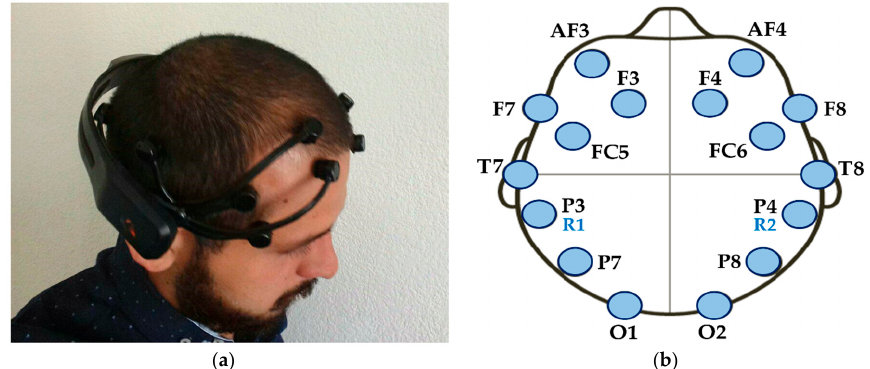
Figure 1. Emotiv EPOC ® wireless EEG headset: ( a ) Placement of the device on the head of the subject; ( b ) Distribution of the electrodes according to the international 10–20 system.